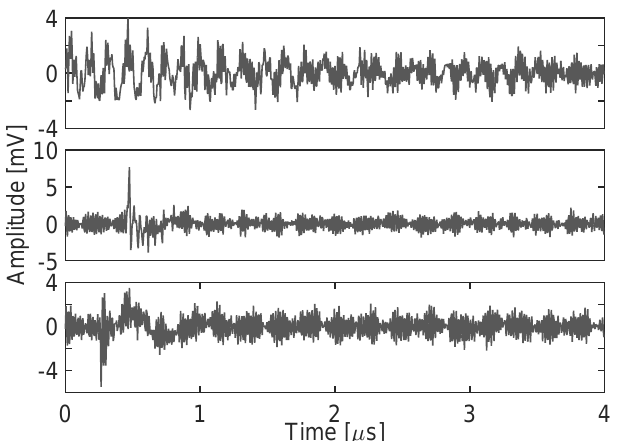
Figure 15. Three types of signals. The upper plot is electrical noise induced and conducted through the wire; the middle plot is one type of pulse corresponding to corona discharges and the lower plot is a pulse derived from discharges in the